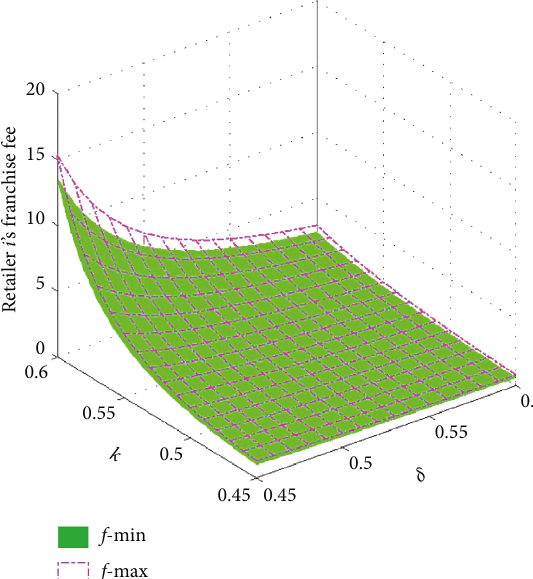
Figure 9: Feasible lower and upper bounds of franchise fees vs. k and δ in the M